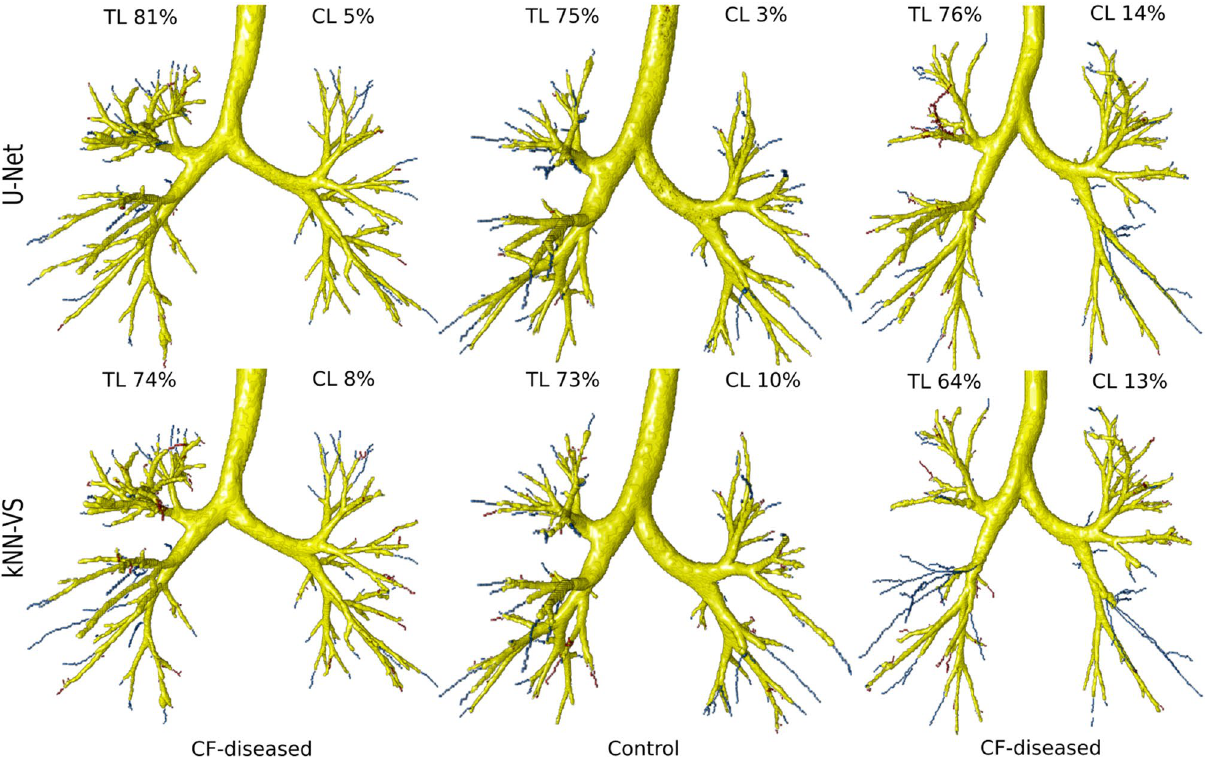
Figure 3. Visualization of predicted airways trees on the CF-CT data, obtained by our U-Net-based method and the kNN-VS method 43 . True positives are displayed in yellow, centerline false negatives in blue and centerline false positives in red. These false negatives and positives are the errors counted in the tree length detected and centerline leakage measures reported in Fig. 2, respectively. The cases displayed correspond to, from left to right, the two U-Net results with Dice score closest to the median of the test Dice measures, and the U-Net result with the lowest Dice